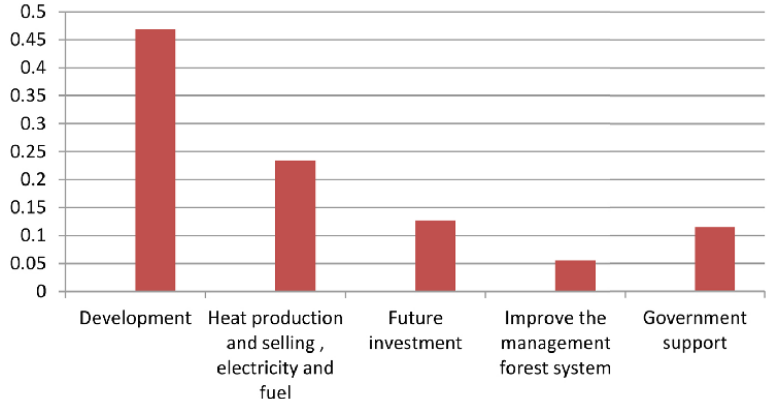
Figure 5: The priority of the opportunities indices in first level (inconsistency rate 0.02), X: Criteria, Y: Weighing value